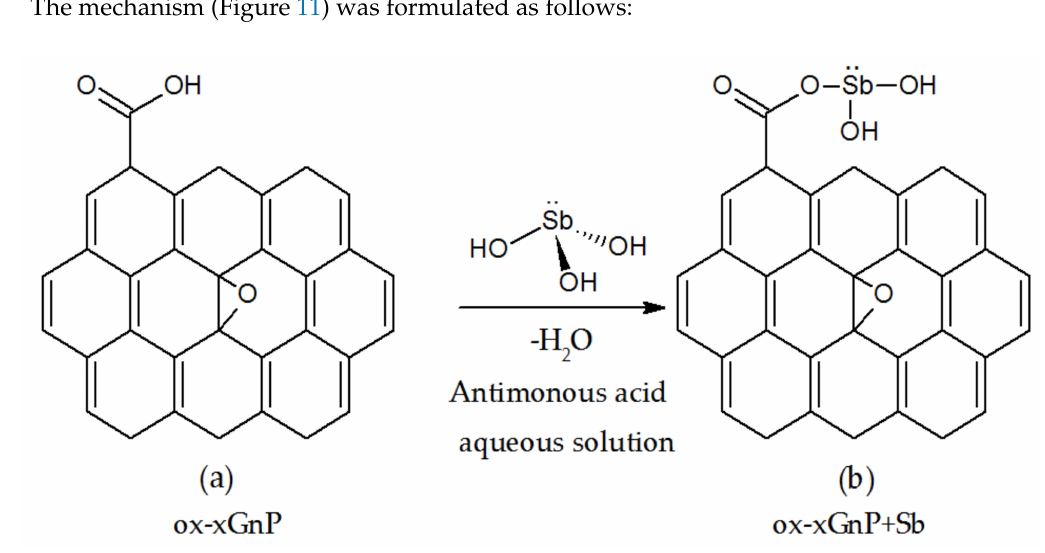
Figure 11. Proposed mechanism for adsorption of Sb (III) on ox-xGnP, ( a ) ox-xGnP, ( b ) ox-xGnP +